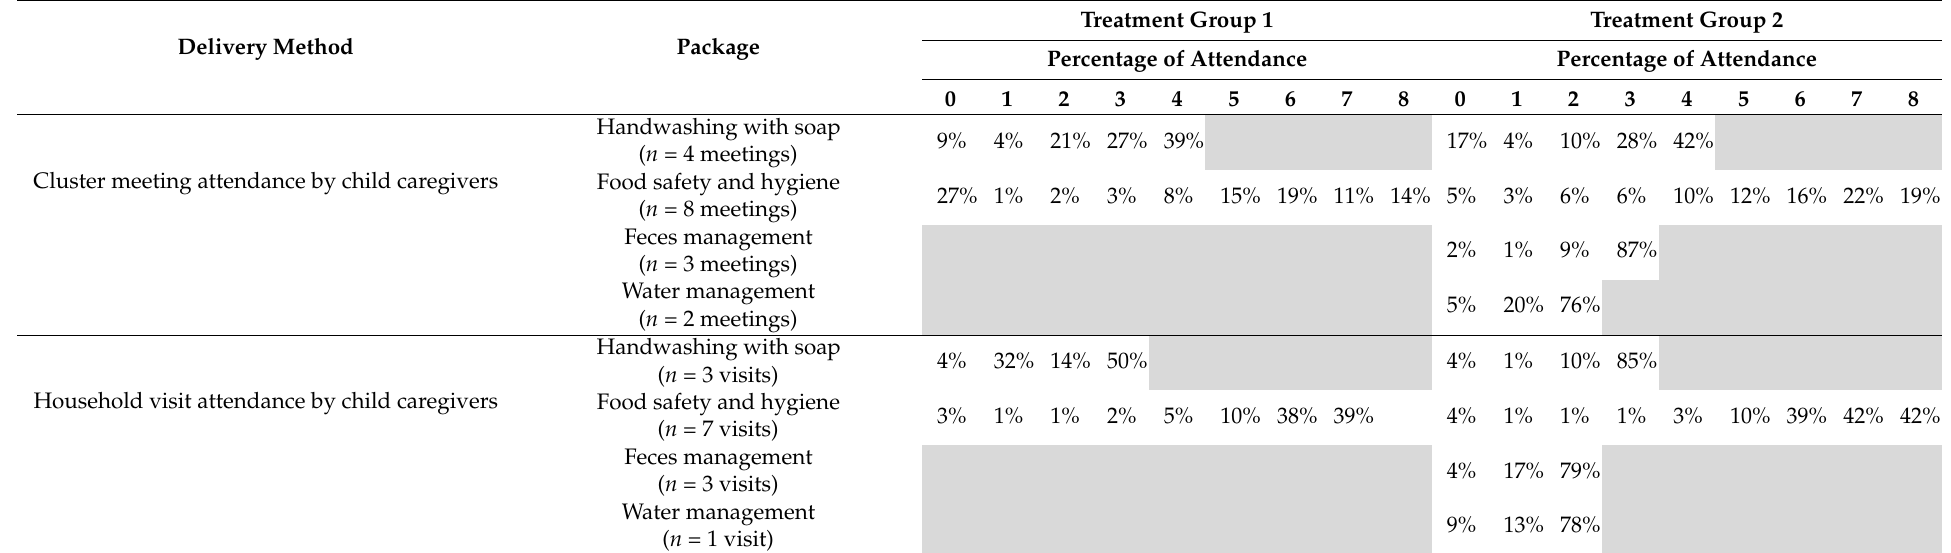
Table 3. Caregivers’ attendance at cluster meetings and household